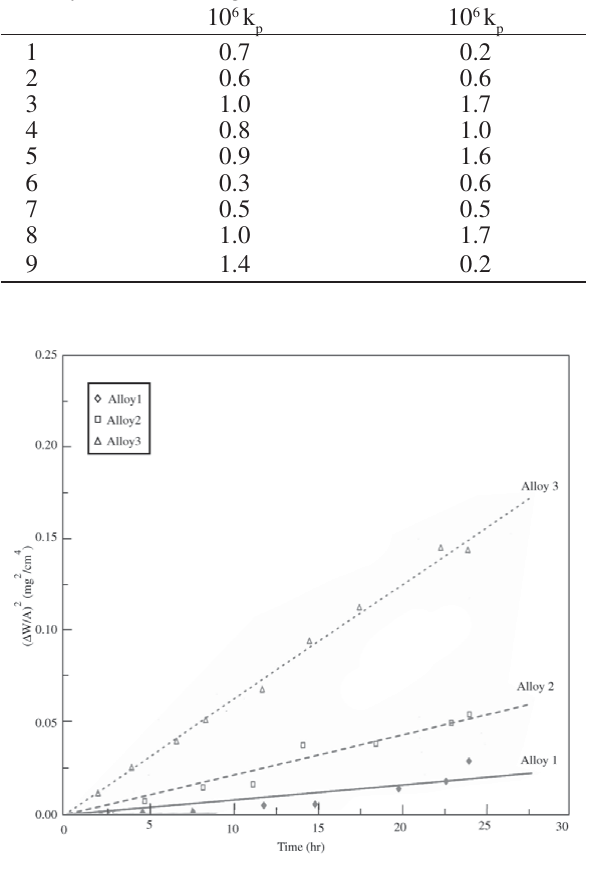
Figure 1. Weight uptake kinetics during isothermal oxidation. Figure 2. Parabolic plots of early stage oxidation.